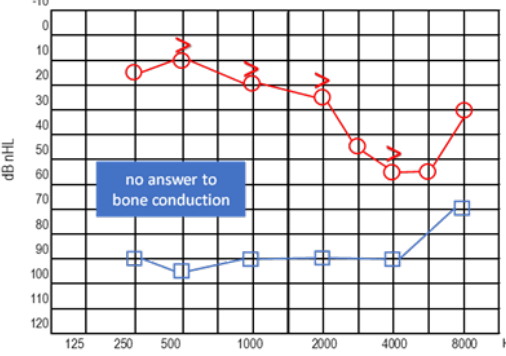
Figure 5. Pure tone audiometry at preoperative evaluation.